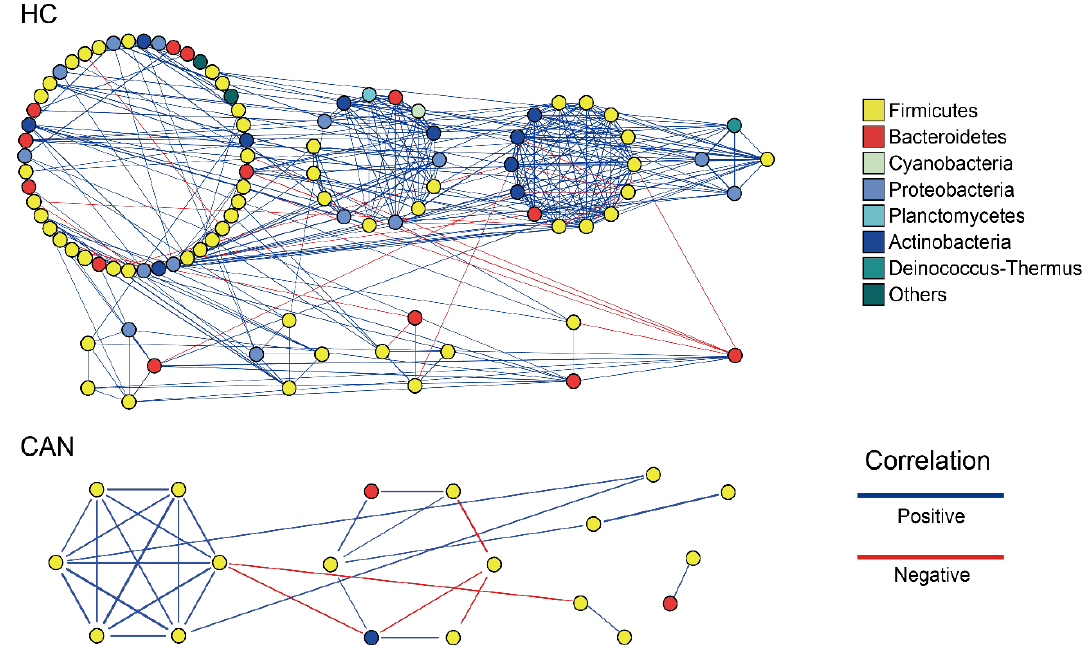
Figure 5. Network analysis of fecal microbiota. The symbiotic pattern in the HC and CAN groups when rho >0.5 and p < 0.05 at the genus level. (Blue and red lines represent positive and negative correlation, respectively. All clusters are colored by phylum).